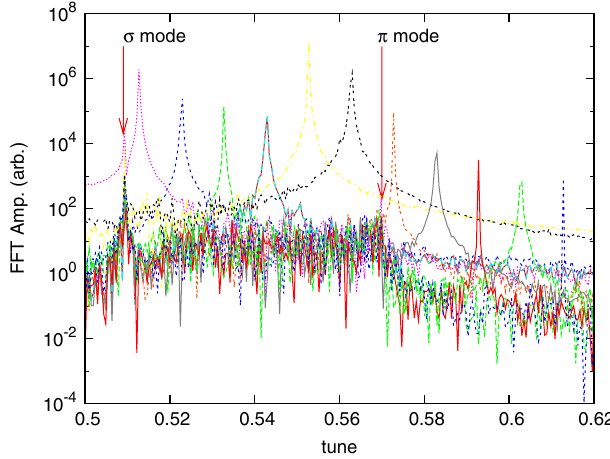
FIG. 6. Horizontal amplitude response of the positron beam to the harmonic excitation frequency and